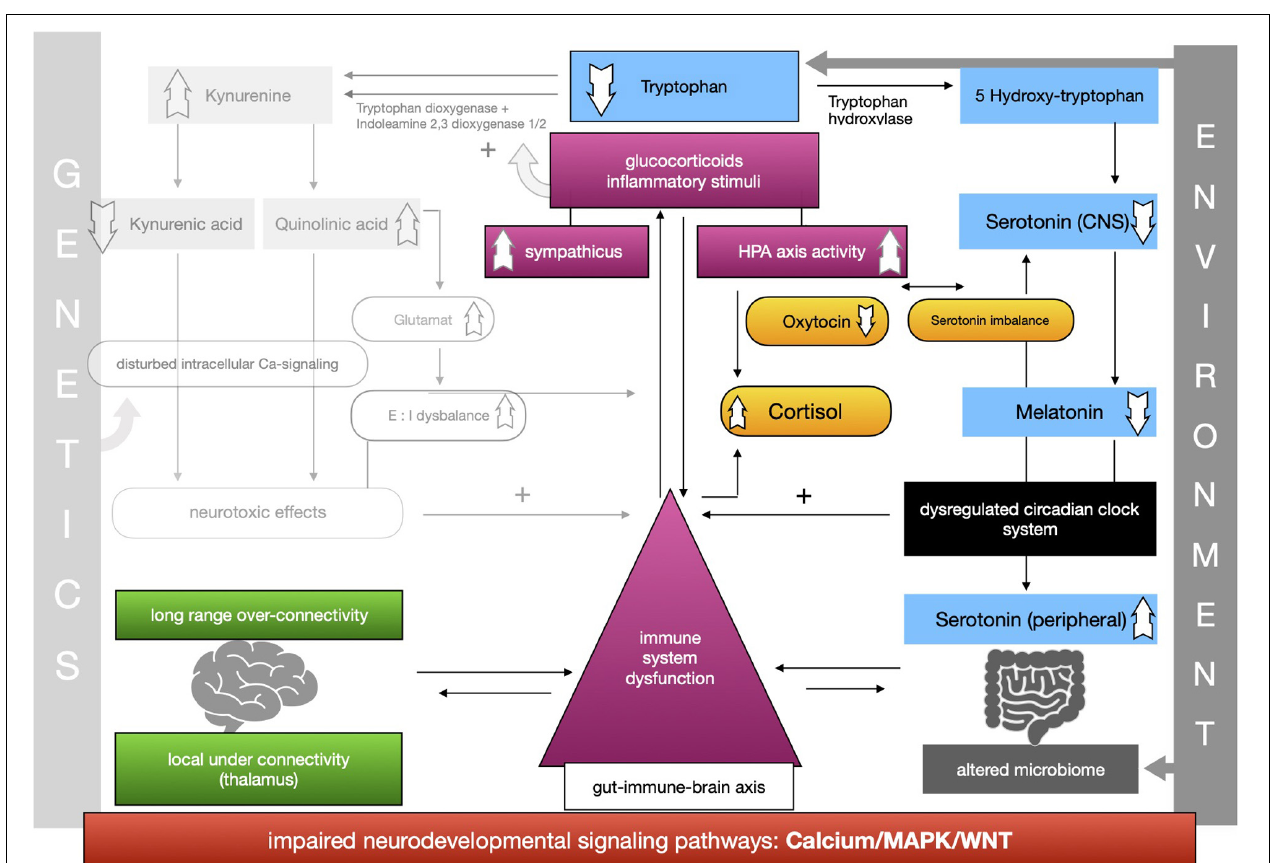
FIGURE 3 | Feedback circuit